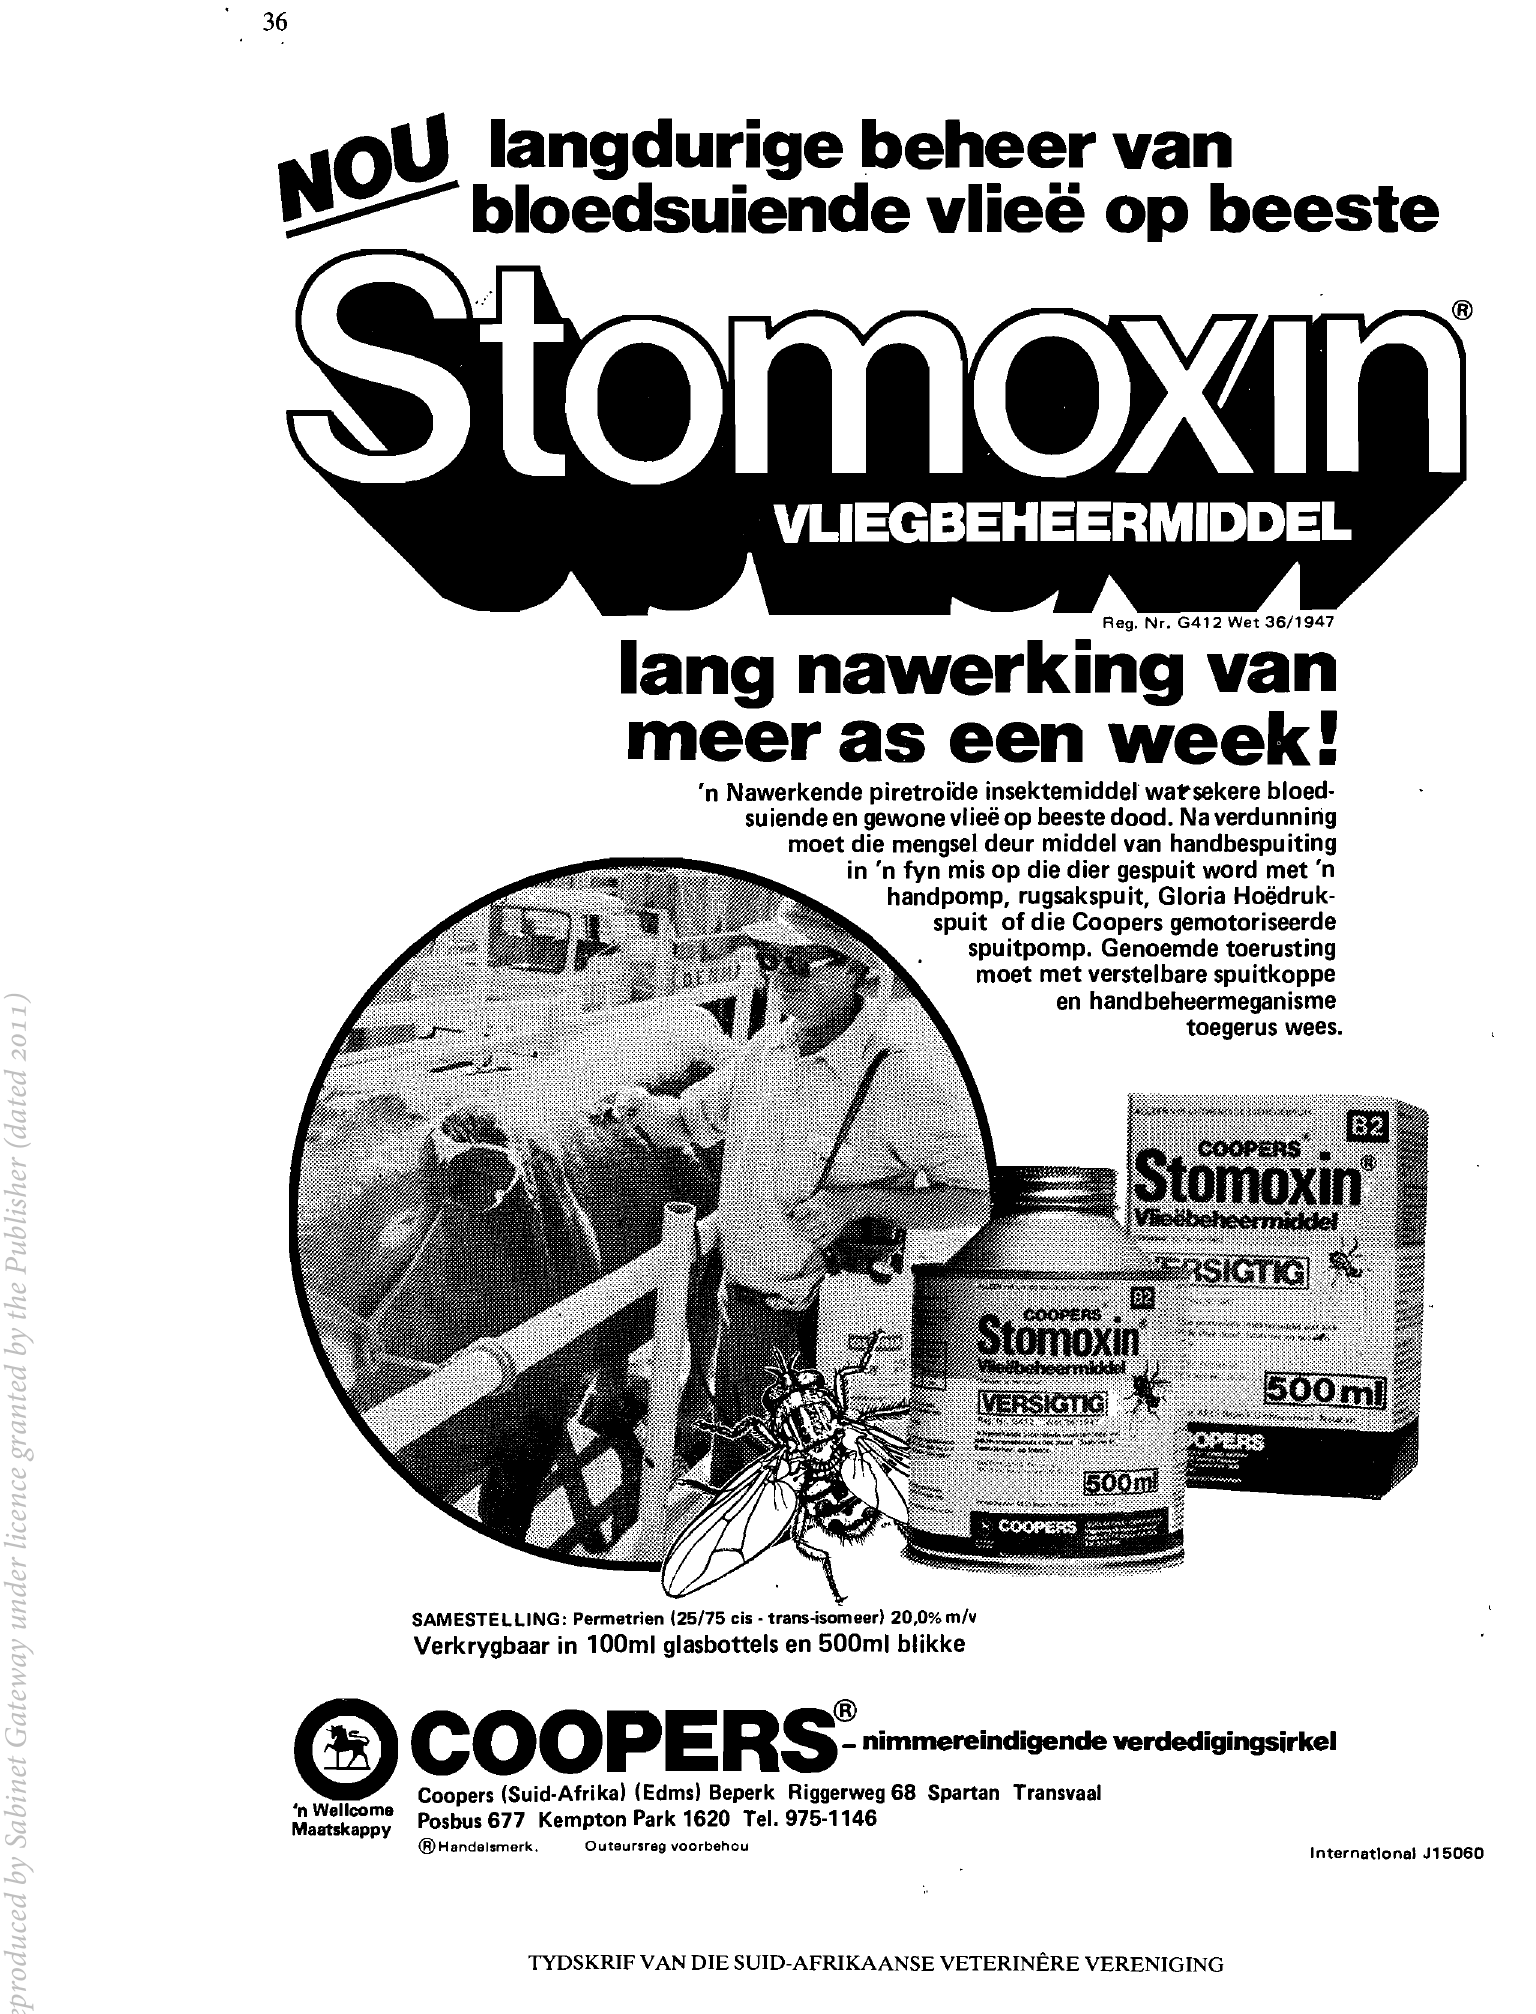
nimmereindigende verdedigingsirkel